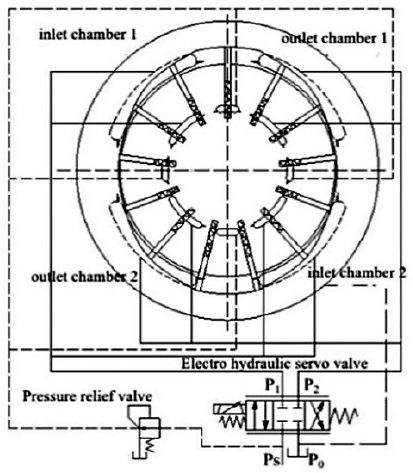
Figure 1. Continuous rotary electro-hydraulic servo motor system.